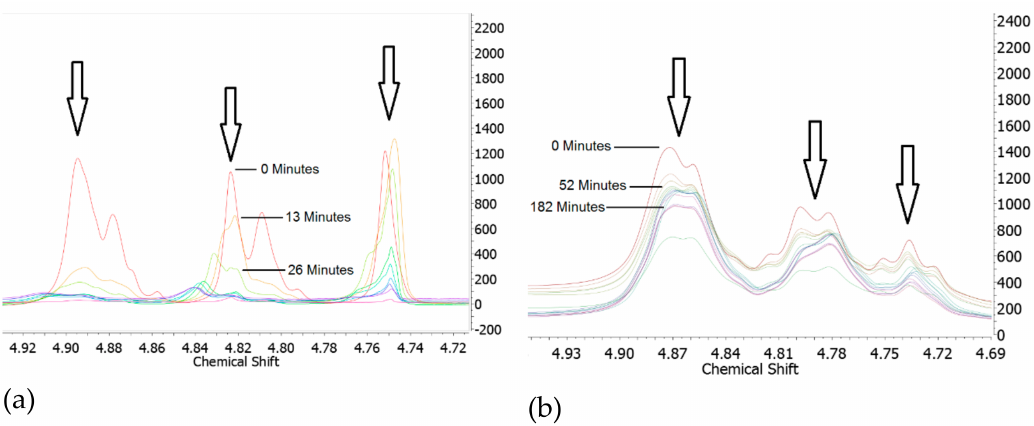
Figure 3. ( a ) Model system without aluminium at 0 ◦ C. ( b ) Model system with aluminium at − 25 ◦